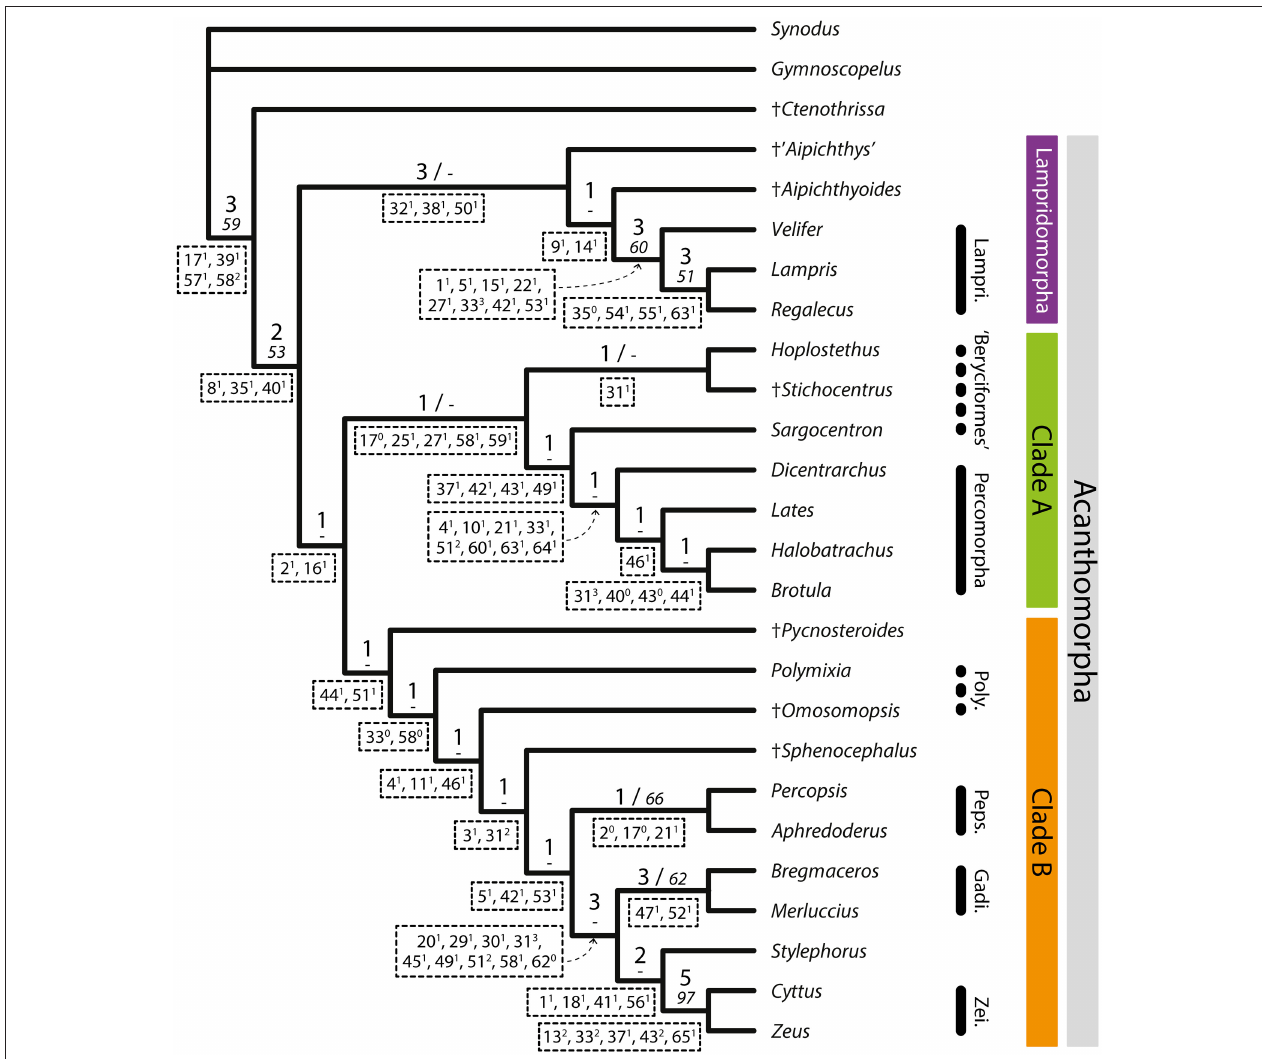
FIGURE 4 | Parsimonious tree obtained from Analysis 1 (complete analysis, extant and fossil taxa). Length = 198, CI = 0.419, RI = 0.684. Support values are above branches: Bremer indexes (bigger font)/bootstrap values (italics). Unambiguous synapomorphies are below